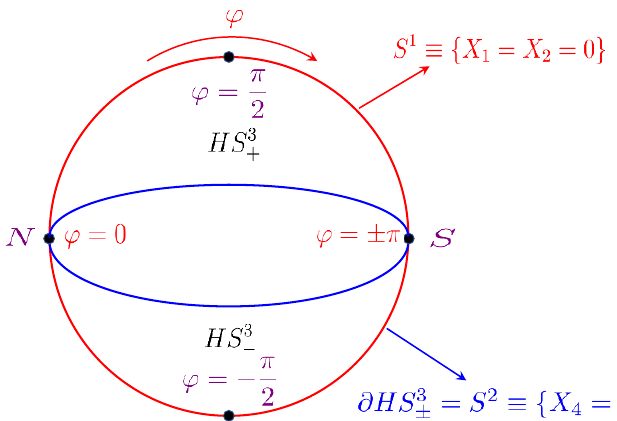
Figure 1 . A schematic 2D representation of S 3 given by X 2 lives on the S 1 de(cid:12)ned by X 1 = X 2 = 0 (red) and parametrized by the angle ’ . The S 3 can be cut into two hemispheres HS 3 by X 4 = 0. The 1D TQFT circle intersects this S 2 at two points identi(cid:12)ed with its North ( N ) and South ( S )